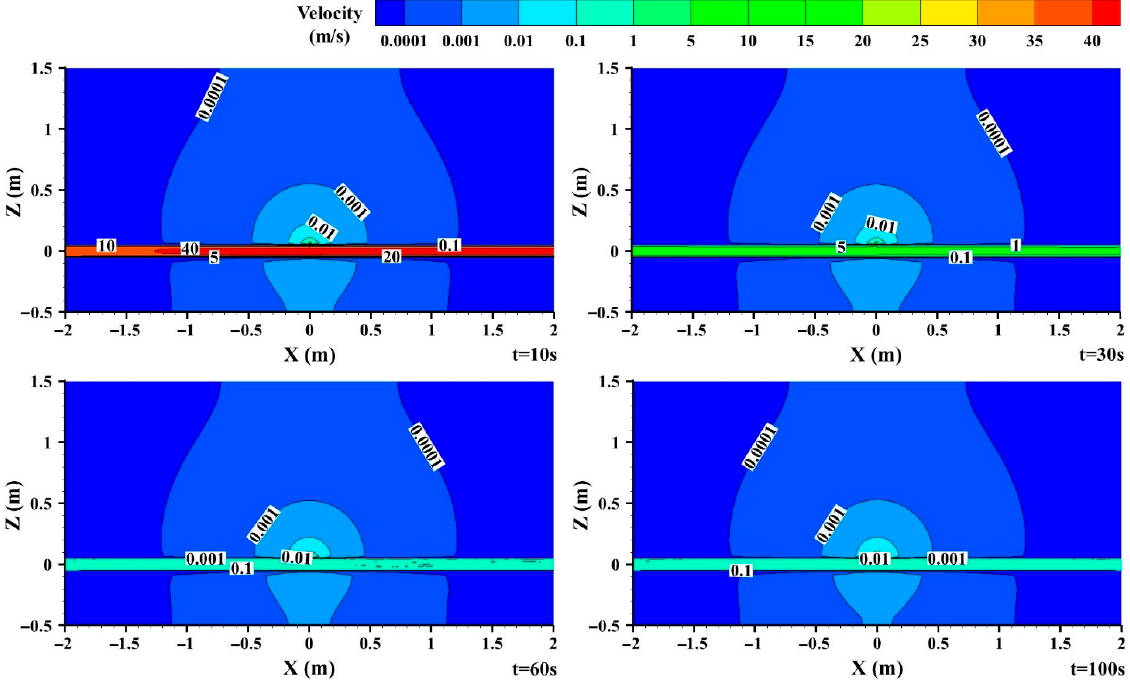
Figure 7. Cloud diagram of velocity distribution at different leakage times.